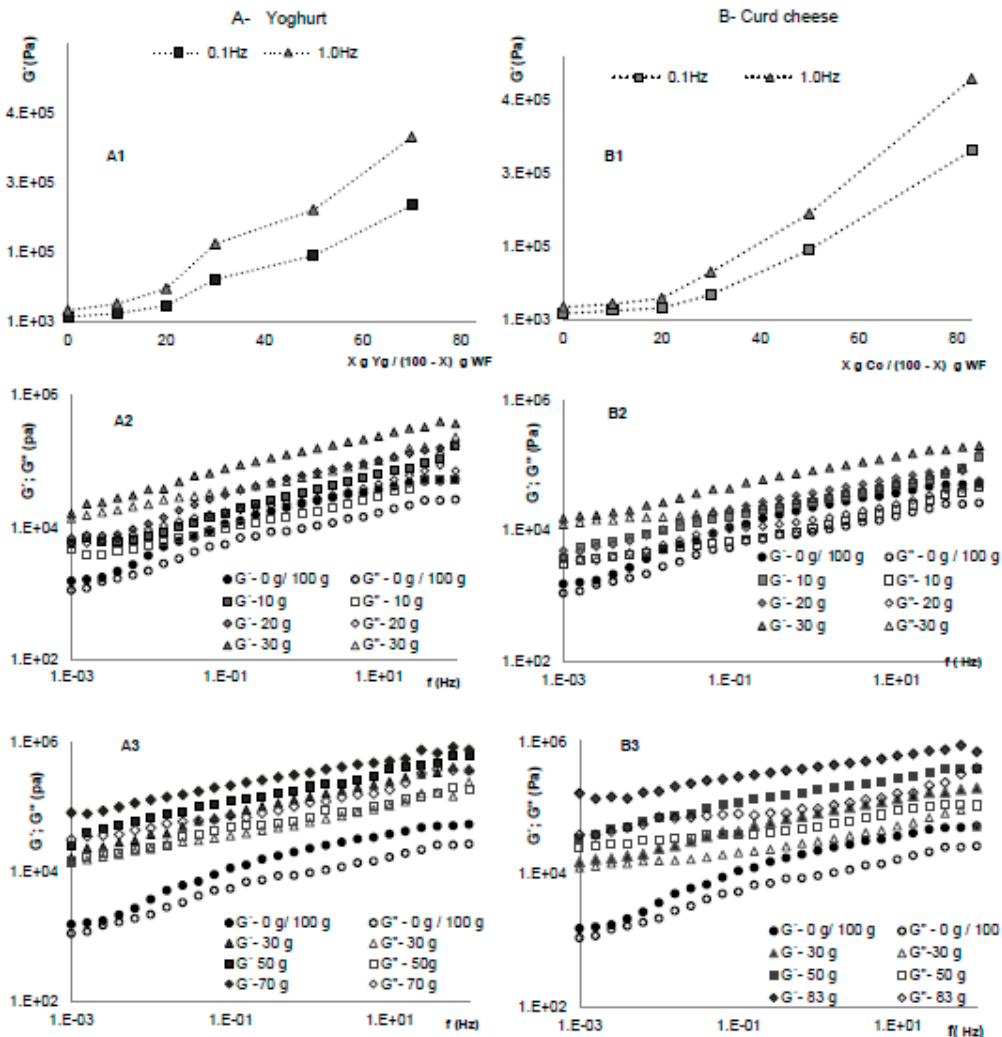
Figure 2. Variation of storage (G´) at 0.1 Hz and 1.0 Hz ( A1 – B1 ) and frequency sweep curves—change of the storage (G’—close symbols) and loss (dissipative (G”)—open symbols) moduli with frequency ( A2 , A3 ; B2 , B3 ), for samples with differents levels of DP: A yoghurt doughs and B for curd cheese doughs.